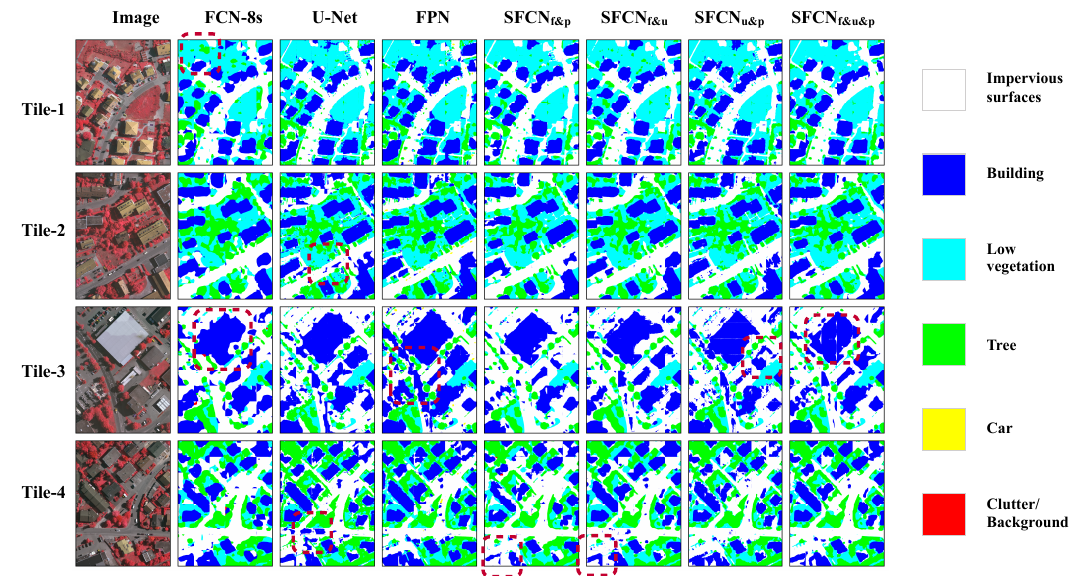
Figure 7. Segmentation results of FCN-8s, U-Net, and FPN and optimized SFCN u & p for testing areas including Tile-1, -2, -3, and -4. Predicted land-covers are represented with six